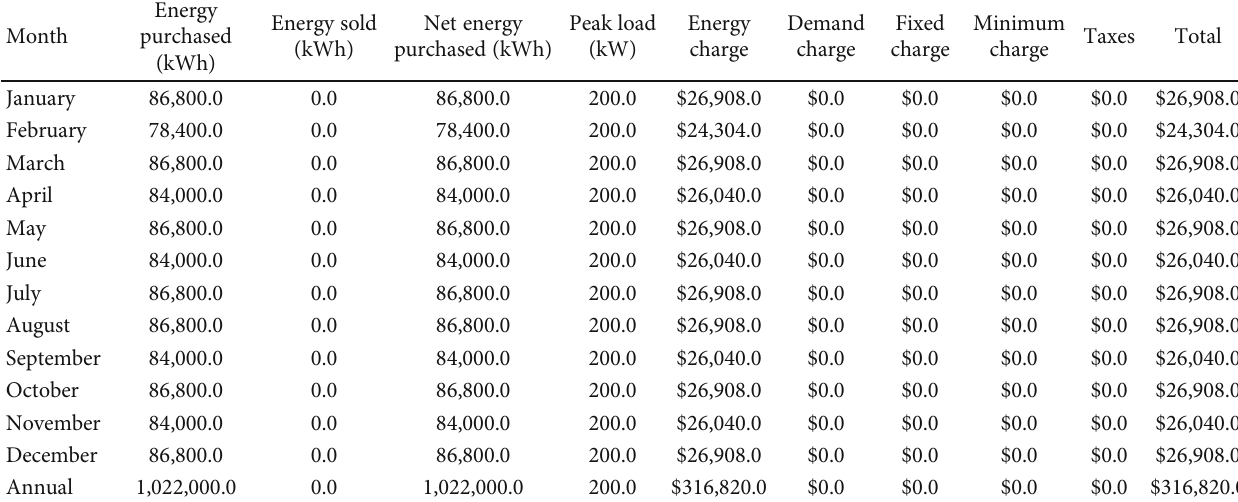
Table 16: Utility monthly summary — current system (Burundi).